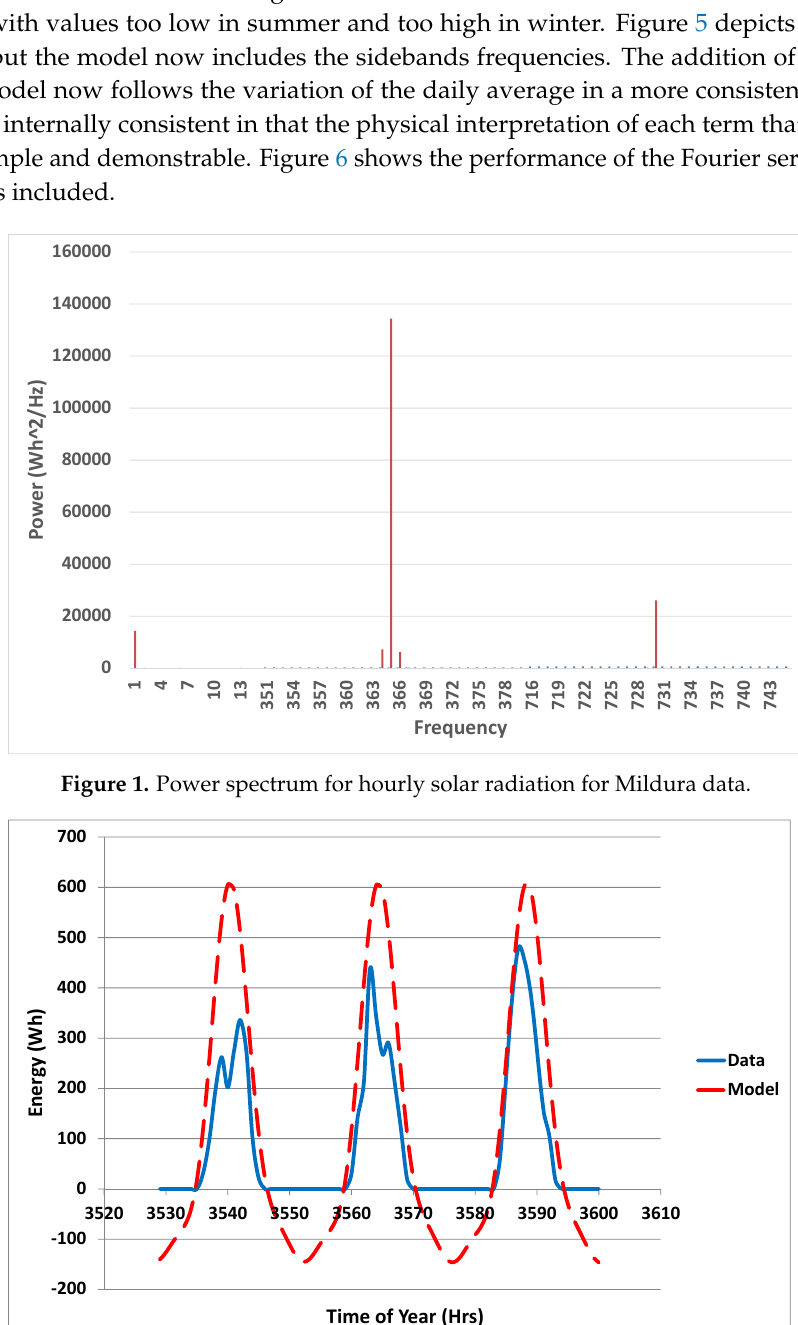
Figure 2. Effect of no sidebands on winter solar